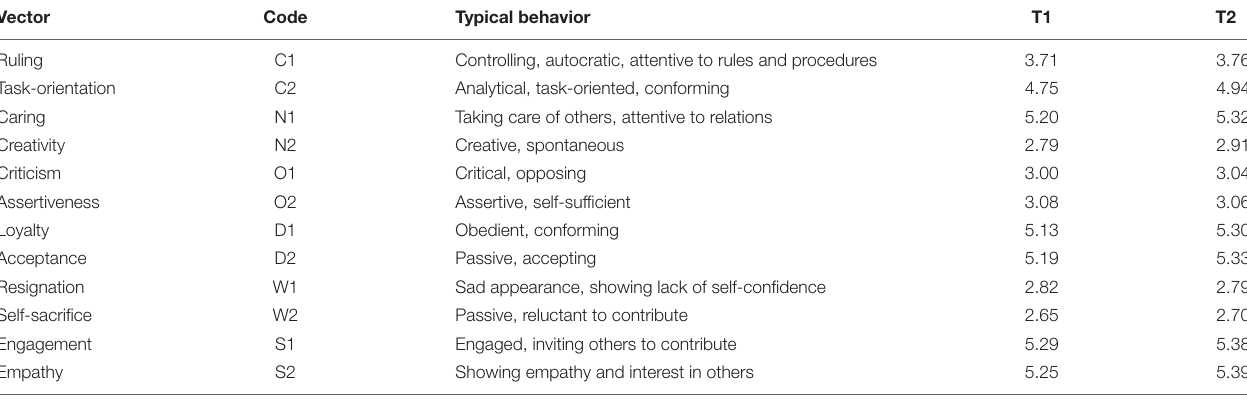
TABLE 3 | Differences in perceived work culture in the experimental municipality.